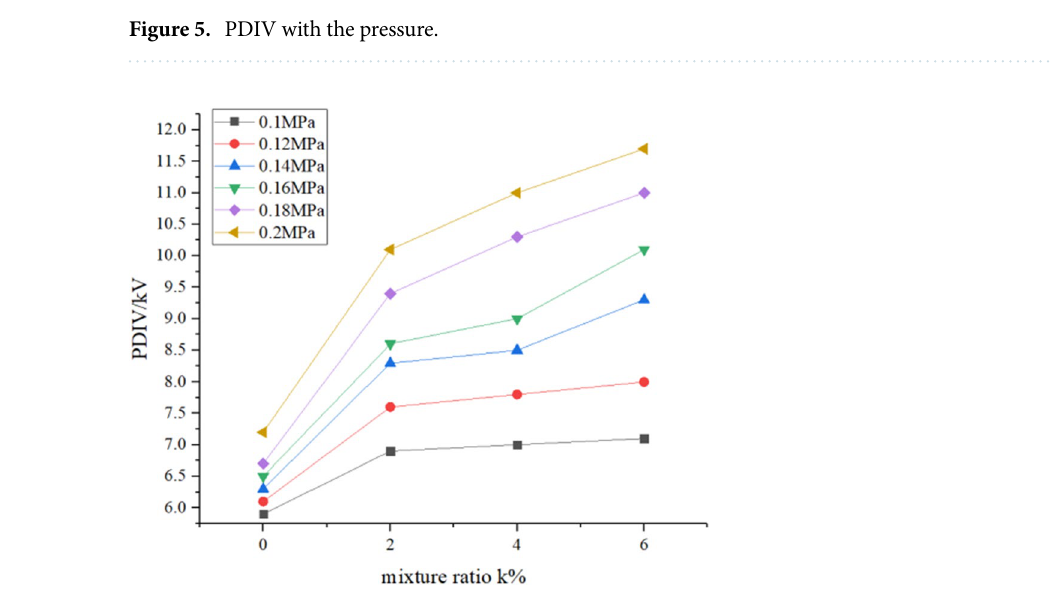
Figure 6. PDIV with the mixing